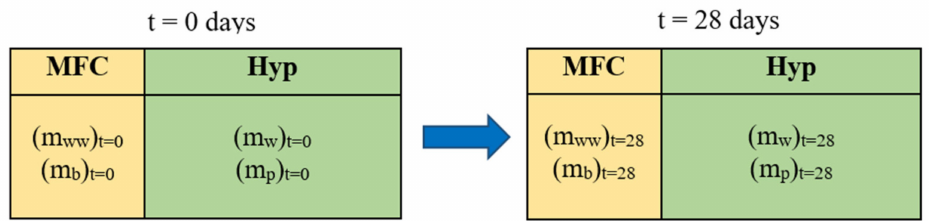
Figure 6. Major phosphate components in the MFC-Hyp system: (m ww ) t=0 and (m ww ) t=28 are phosphate mass in wastewater in the MFC at Day 0 and 28, respectively; (m b ) t=0 and (m b ) t=28 are phosphate mass in bacteria in the MFC at Day 0 and 28, respectively; (m w ) t=0 and (m w ) t=28 are phosphate mass in water in the Hyp vessel at Day 0 and 28, respectively; (m p ) t=0 and (m p ) t=28 are phosphate mass in plants in the Hyp vessel at Day 0 and 28,